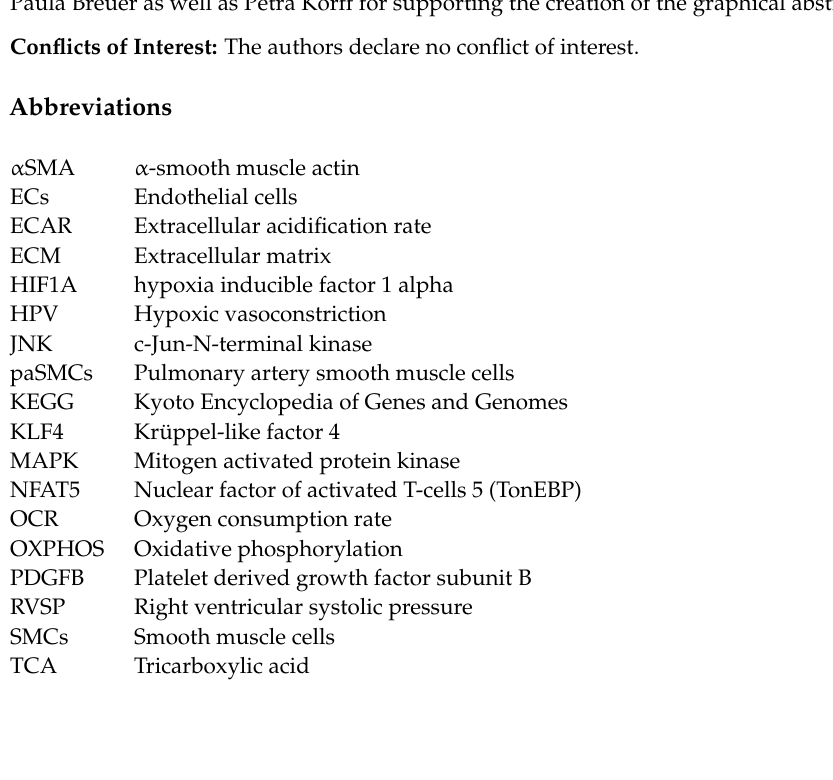
Figure S4: Immunofluorescence-based detection of NFAT5 in mouse lungs, Figure S5: Principal com- ponent analyses of lung RNA samples, Figure S6: Expression of SMC marker genes in hypoxic mouse lungs, Figure S7: Analysis of mpaSMC proliferation in hypoxic mouse lungs, Figure S8: Seahorse-based analysis of the ECAR of mpaSMCs, Figure S9: ROS detection in hypoxia-exposed mpaSMCs, Figure S10: Scavenging of ROS in hypoxic mpaSMCs by MitoTEMPO, Figure S11: Echocardiographic assessment of PAT and ET values, Figure S12: Echocardiographic structural and functional analysis of the left ventricle, Figure S13: Echocardiographic results showing RV area changes, Figure S14: Analysis of the arterial SMC coverage in hypoxic mouse lungs after 21